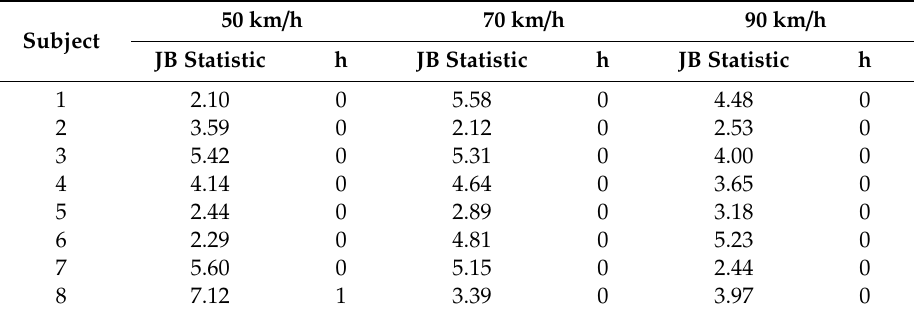
Table 2. Results of Jarque–Bera test for subjects 1–8 on straight